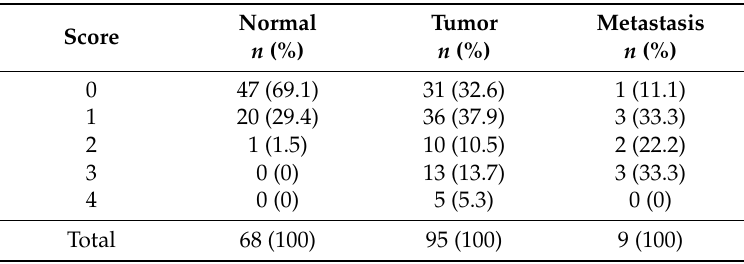
Figure 1. CCAAT/enhancer-binding protein β ( C/EBP β ) expression in human lung cancer tissues. ( A ) Patients-derived lung cancer tissue arrays were examined for C/EBP β expression using the immunoperoxidase method. Staining results were graded according to the intensity and proportion of positive area. Images were captured at a magnification of 200X by using the Aperio ImageScope software. Scale bars: 200 μ m. ( B ) The histogram represents the percentage of the immunohistochemistry (IHC) score for C/EBP β in 68 normal tissues, 95 primary, and 9 metastatic tumor tissues. The statistical significance was determined using the t -test, p < 0.05. ( C ) The association between C/EBP β mRNA expression and overall survival of adenocarcinoma (whole dataset) and squamous cell carcinoma patients (GSE37745) was analyzed using the Kaplan–Meier Plotter. Hazard ratio (HR) significance was found with log-rank tests. Table 1. Immunohistochemistry (IHC) scoring of C/EBP β .